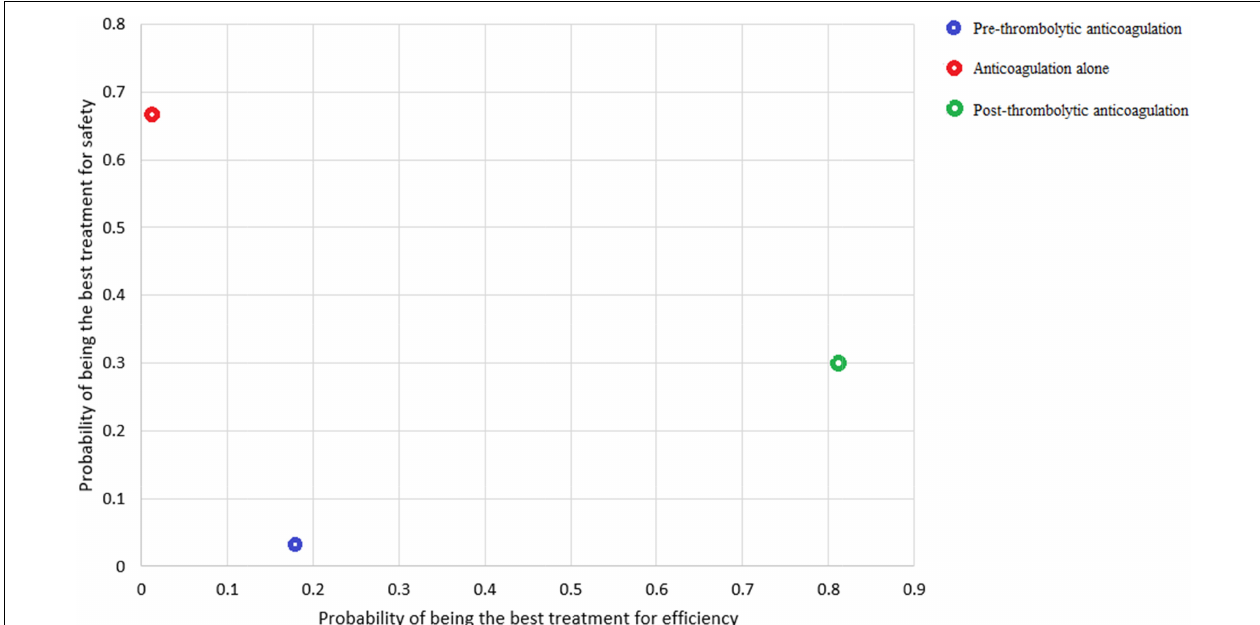
FIGURE 5 | Ranking plot in consideration of efficiency and